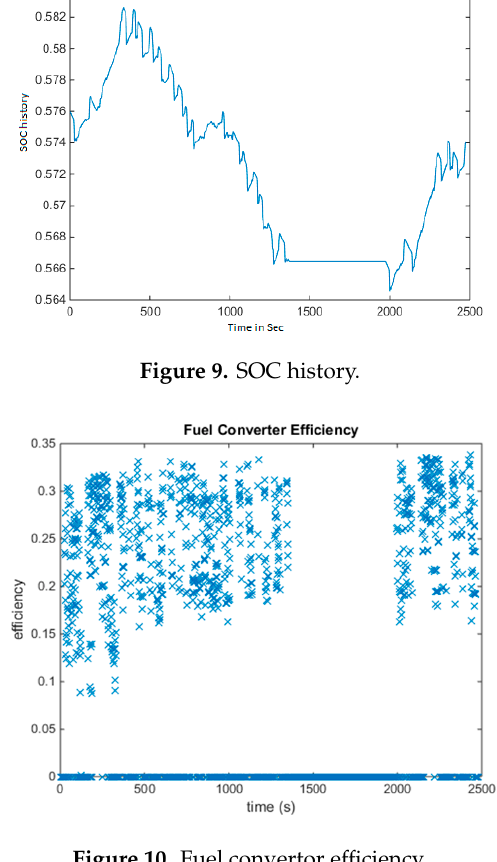
Figure 10. Fuel convertor efficiency.